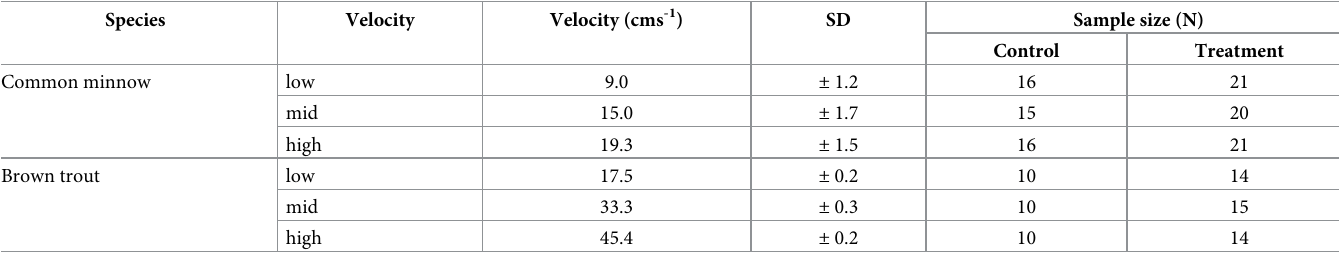
Table 1. Summary of mean unidirectional flow velocities ( ± SD) and sample sizes for low, medium and high velocity treatments for common minnow ( Phoxinus phoxinus ) and brown trout ( Salmo trutta